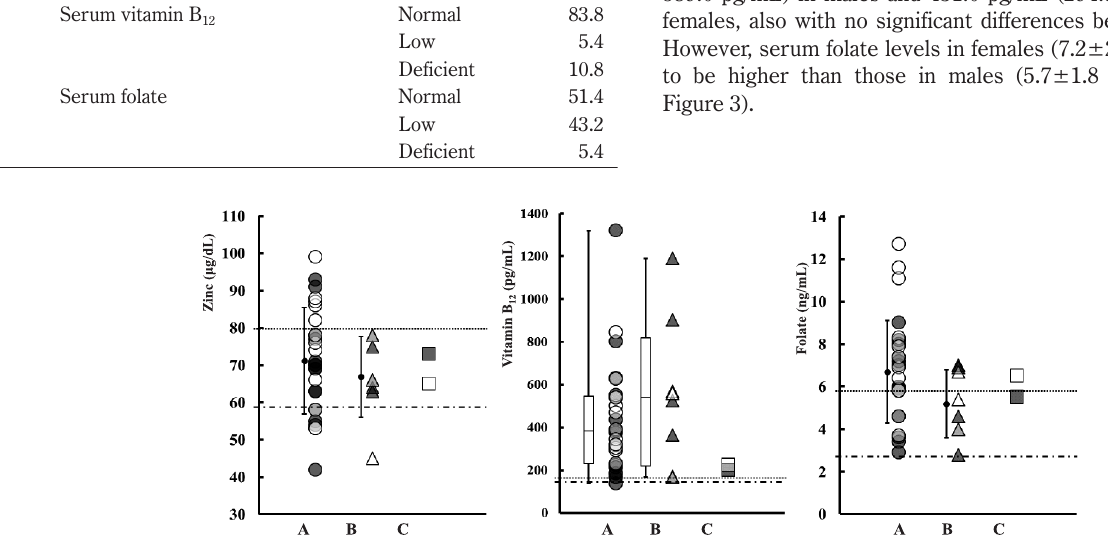
Figure 2 Relationship between type of malignancy and serum zinc, vitamin B 12 and folate levels. A: Malignant lymphoma. B: Leukaemia. C: Multiple myeloma. Zinc and folate are expressed as means±standard deviations. Vitamin B 12 is expressed as medians with interquartile ranges. Dotted lines show cut-off values between sufficient and potentially deficient values. Chain lines show cut-off values between potentially deficient and deficient values.